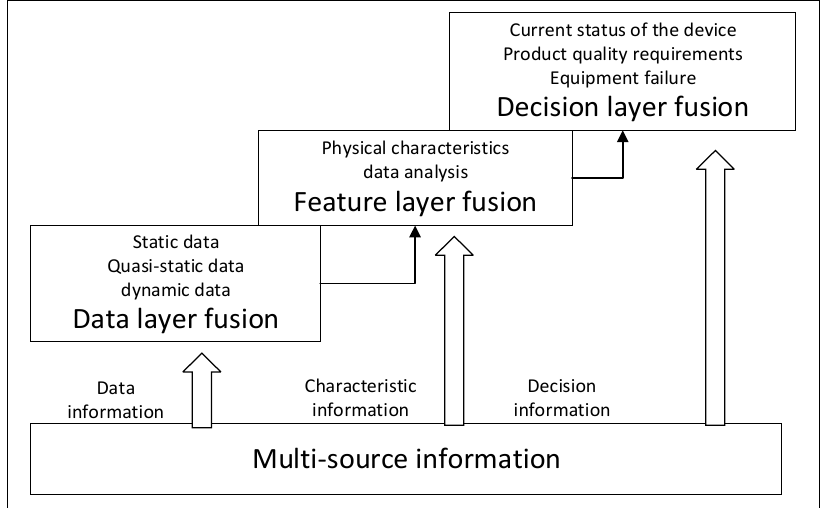
Figure 7. Application flow chart of information fusion.